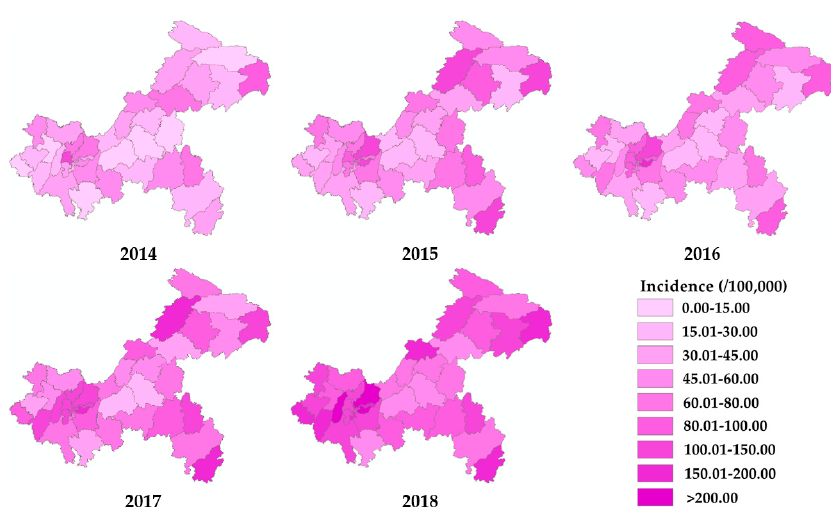
Figure 2. Incidence maps of varicella in Chongqing from 2014 to 2018.